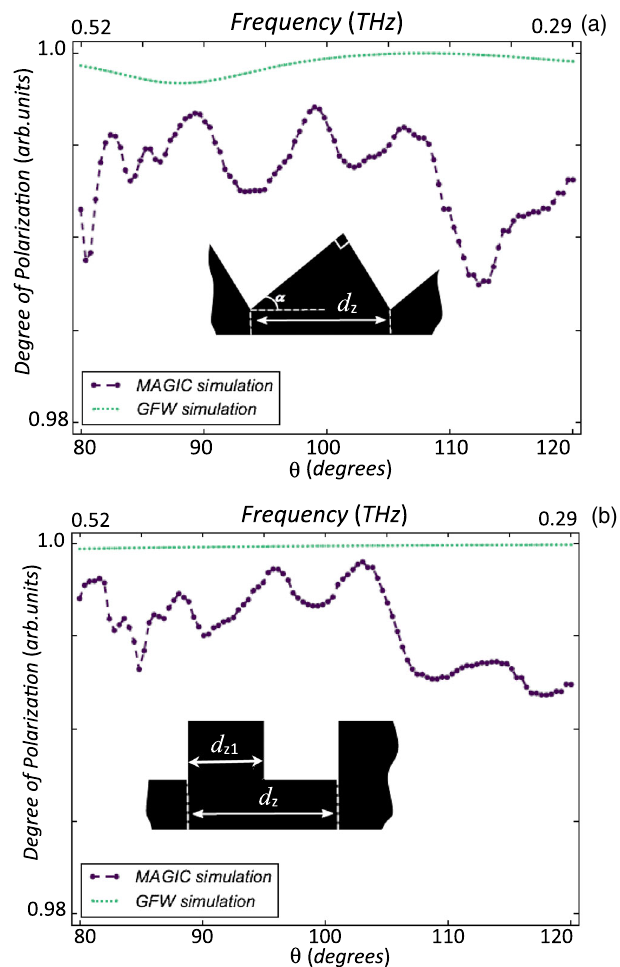
¼ 0 . 7 mm FIG. 11. The DoP of cSPr from the 10 mm long, d z period grating obtained by using the semianalytical code GFW and the 3D particle-in-cell code MAGIC , for two different grating profiles: (a) sawtooth ( α ¼ 30 °, height 0.25 mm see inset) and ¼ d (b) strip (height 0.25 mm and 2 d see inset). The gratings z 1 z were excited by 0.1 nC, 8 MeV, 300 fs electron bunches. In both simulations it was assumed that the detectors were located at azimuthal angle φ ¼ 0 ° and the results were integrated over the detector aperture (20 mm diameter).